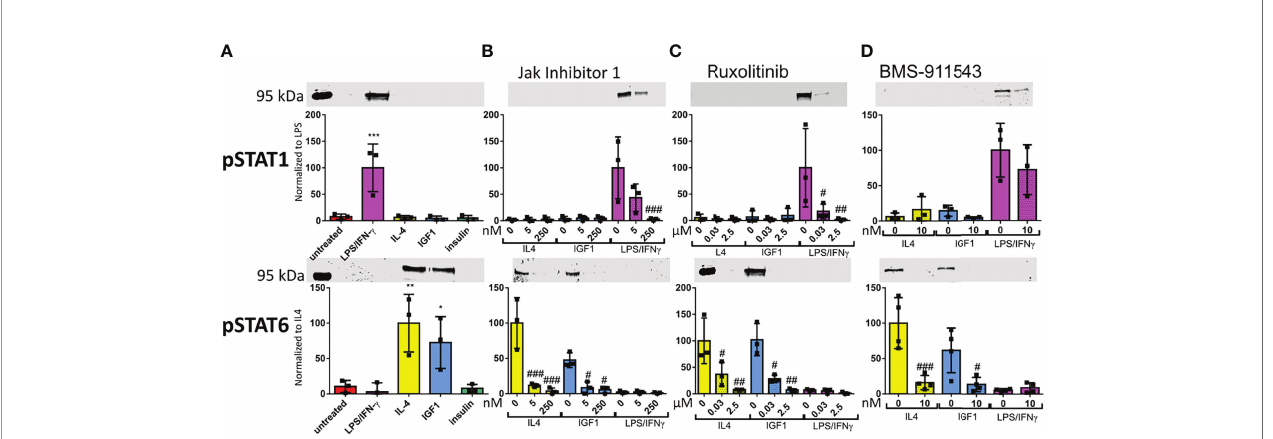
FIGURE 5 | LPS/IFN g cause STAT1 phosphorylation, whereas IL4 and IGF1 cause STAT6 phosphorylation (A – D) Representative western blots and analysis for STAT1 and STAT6 phosphorylation after 10 min treatment with LPS/IFN g (10/2 ng/mL), IL4 (20 ng/mL) or IGF1 (10 ng/mL) without JAK inhibitor (A) , or in the presence of different concentrations of InSolution Jak Inhibitor 1 (B) , Ruxolitinib (C) or BMS-911543 (D) . Data is normalized to total protein stain, and for pSTAT 1 LPS/IFN g without inhibitor is set to 100 and for pSTAT6 IL4 without inhibitor is set to 100. Single measurements are shown. Bars represent mean ± SD. *p<0.05, **p<0.01 and ***p<0.001 when compared to untreated without inhibitor. # p<0.05, ## p<0.01 and ### p<0.001 when compared to the same treatment without